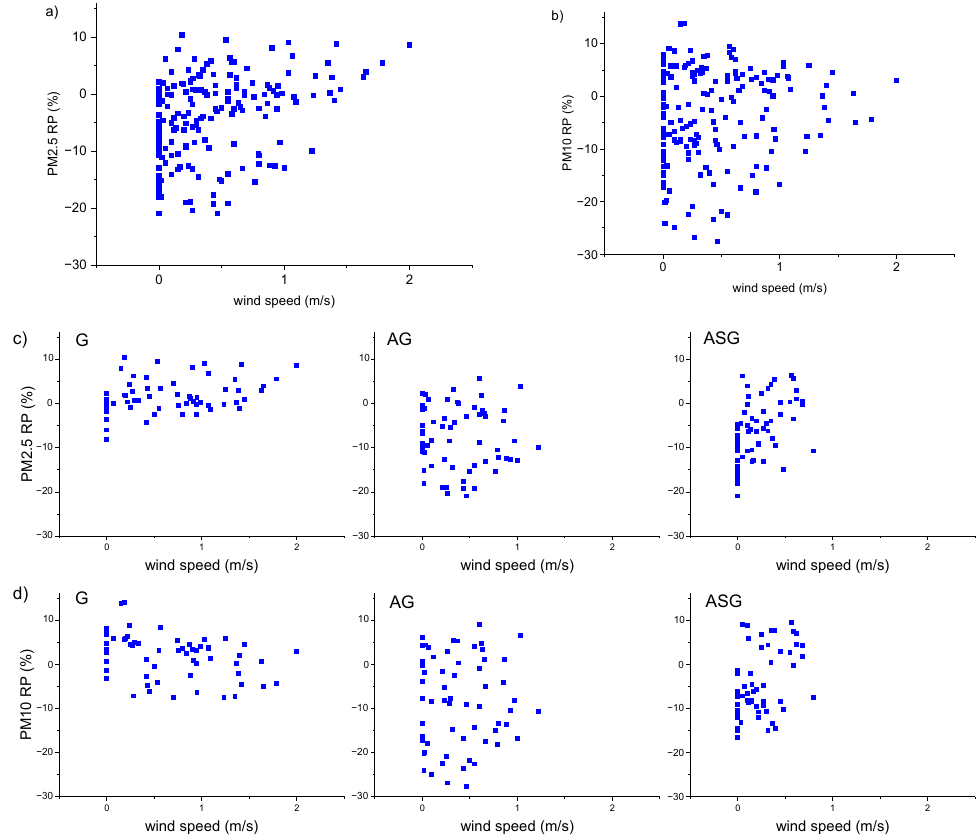
Figure 7. Scatter plots of all the data points during mild-wind periods from all vegetation types: ( a ) wind speeds and PM 2.5 removal percentages, ( b ) wind speeds and PM 10 removal percentages. Scatter plots of the data points during mild-wind periods for different vegetation types separately: ( c ) wind speeds and PM 2.5 removal percentages, ( d ) wind speeds and PM 10 removal percentages. G: open grassland; AG: arbor-grass woodland; ASG: arbor-shrub-grass woodland.